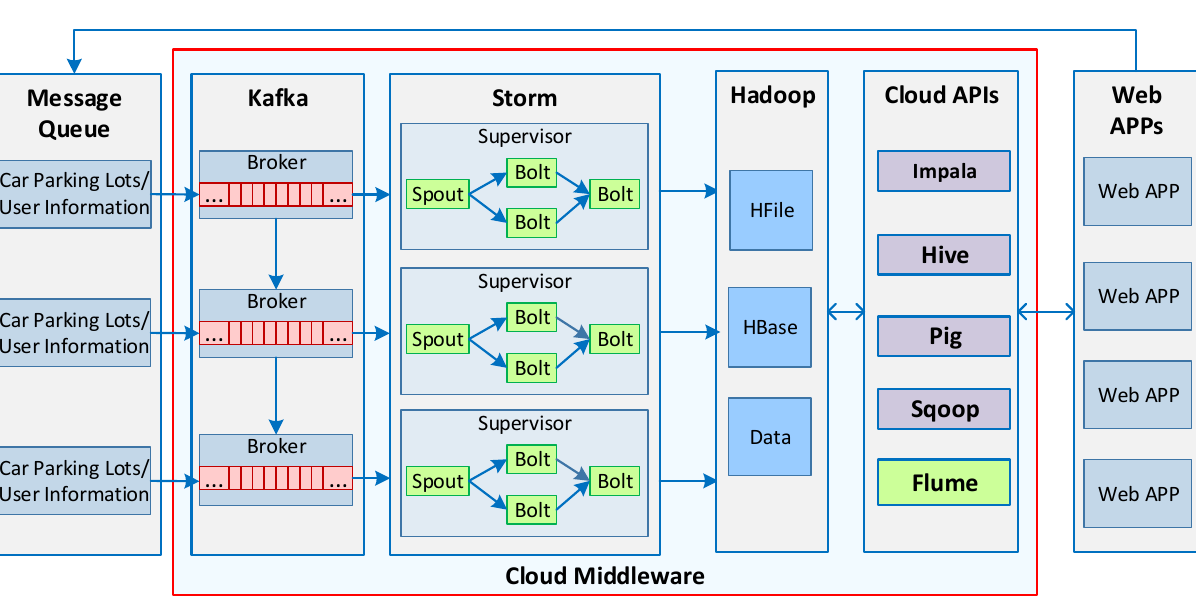
Figure 9 . The cloud solutions for the car parking